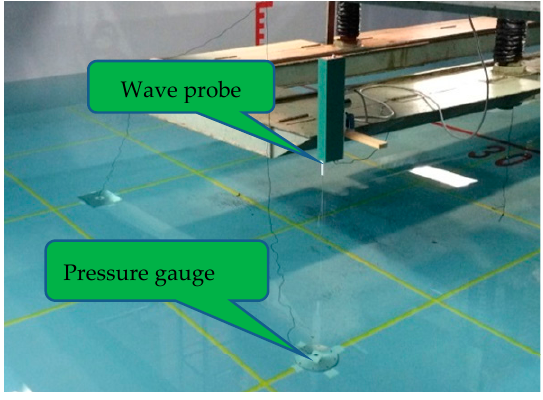
Figure 1. Wave probe and pressure sensor set at 24.6 m from wavemaker.